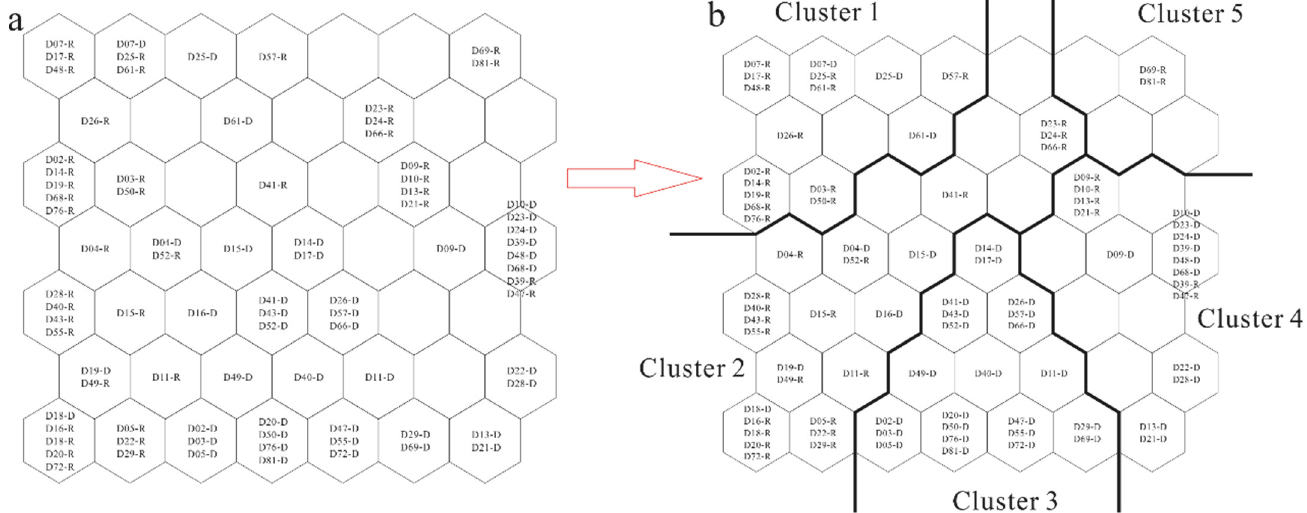
Figure 12. SOM-based clustering of the groundwater samples collected during the rainy and dry seasons (( a ). Different neurons contain samples ( b ). Different clusters contain samples).